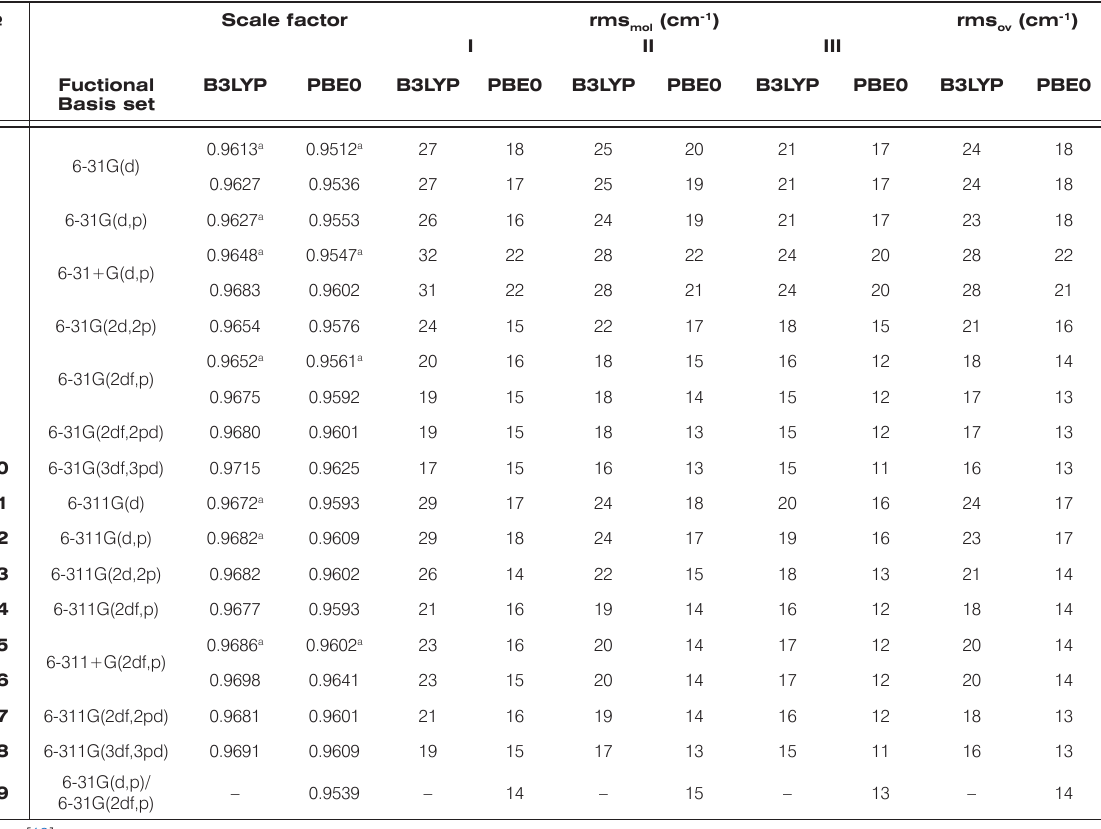
Table 8. Scale factors and rms values.